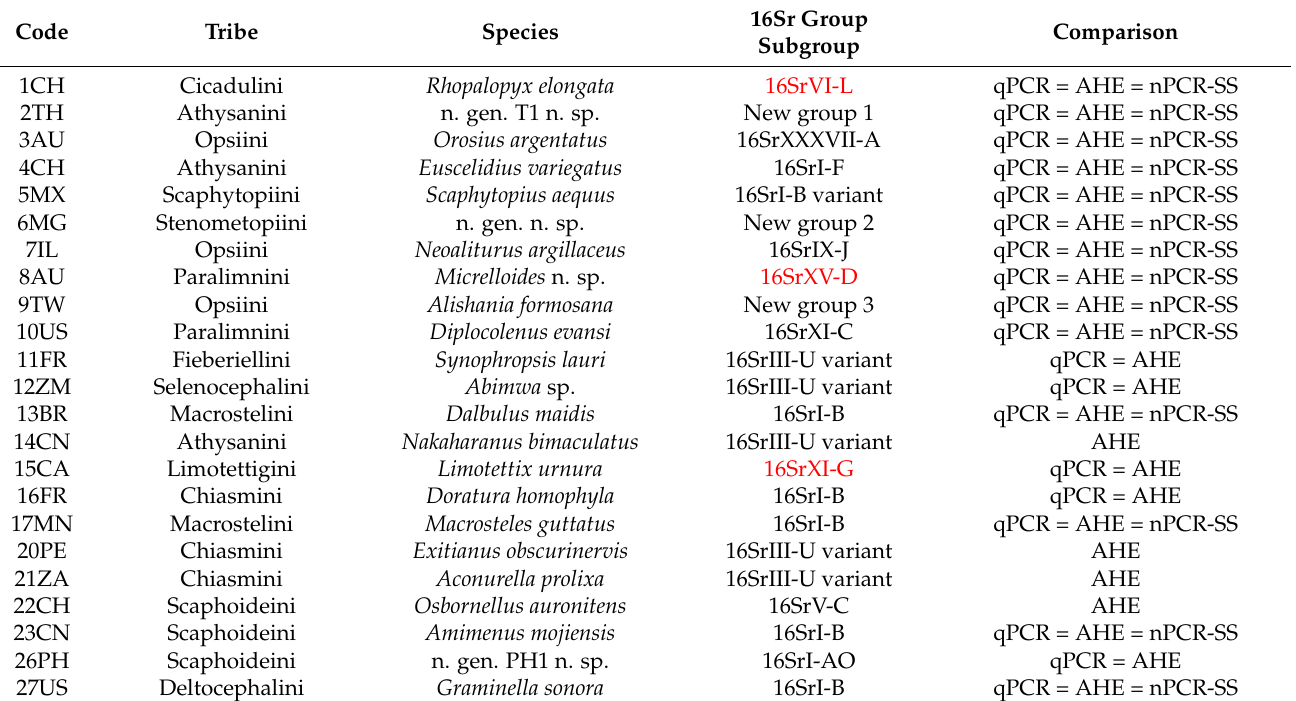
Table 3. Identification and classification of the 23 phytoplasma strains detected in leafhoppers analyzed in this study. Newly designated subgroups are indicated in red. qPCR: quantitative PCR; nPCR-SS: nested PCR followed by Sanger sequencing; AHE: Anchored Hybrid